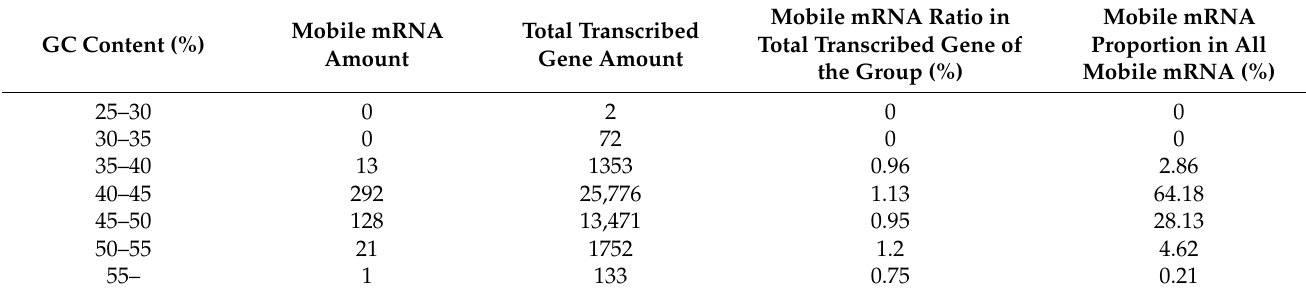
Table 2. GC content and transfer ratio in the rootstock of